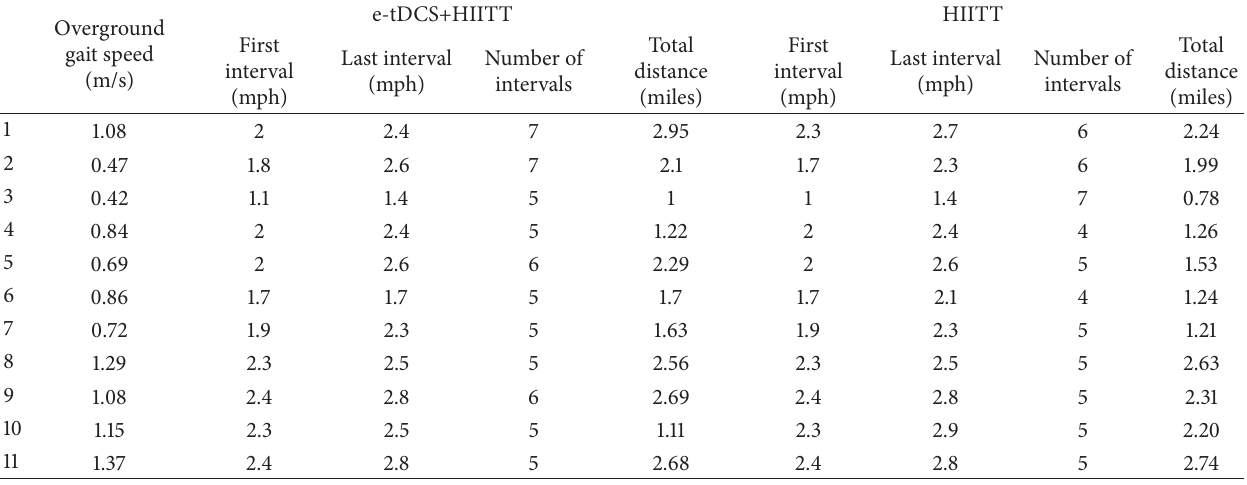
Table 2: Treadmill speeds and distance covered for each participant during treadmill training. Overground